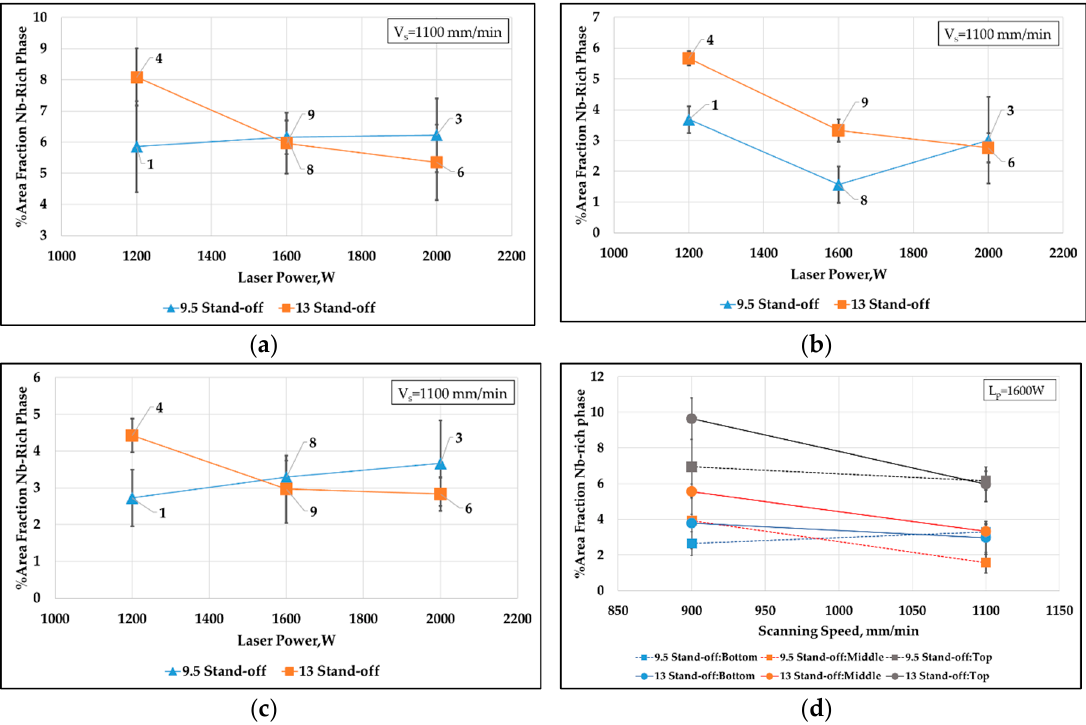
Figure 9. Plots depicting the effect of laser power and laser stand-off distance on ( a ) top region; ( b )